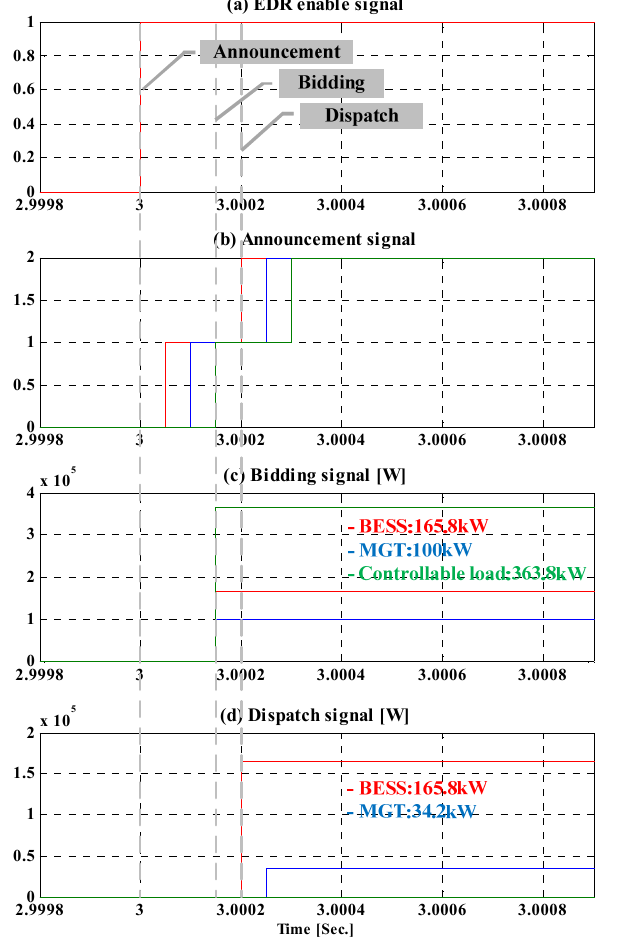
Figure 16. Decision making procedure for EDR power dispatch in case